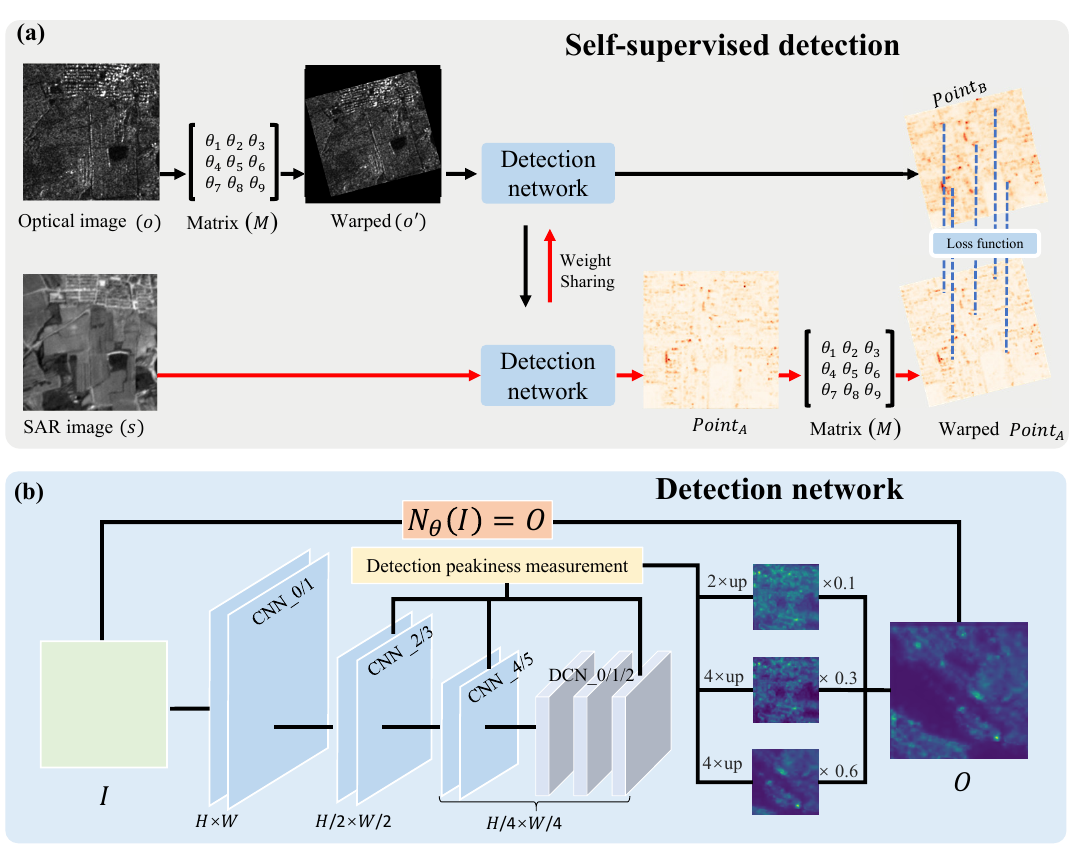
Figure 1. (a)Self-supervised detection. First, a randomly selected image from a strictly pixel-aligned remote sensing image is subjected to a projection transformation. Then, the warped image and the other image are simultaneously fed into the detection network with shared weights for feature point extraction. Finally, the losses of corresponding keypoints are calculated by the projection transformation relationship. (b)An overview of detection network. N θ ( I ) = O represent the parameterization of detection network , and θ denotes parameters that the network needs to be trained. The peakiness measurement of keypoints are calculated from the local spatial( α c ij ) and channel domains( β c ij